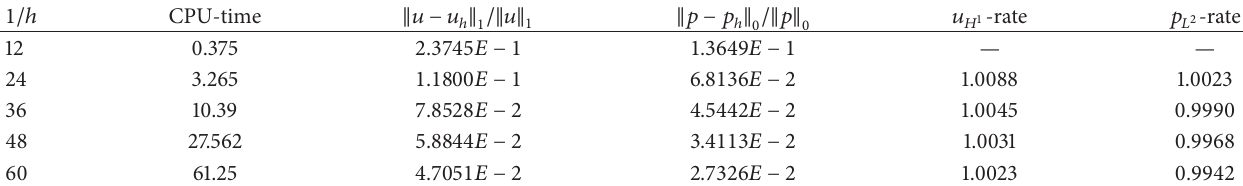
Table 1: Numerical results for the penalty method with ] = 1.0𝑒 − 4 , 𝛼 = 1.0𝑒 − 4 , and 𝑟 = 3 .